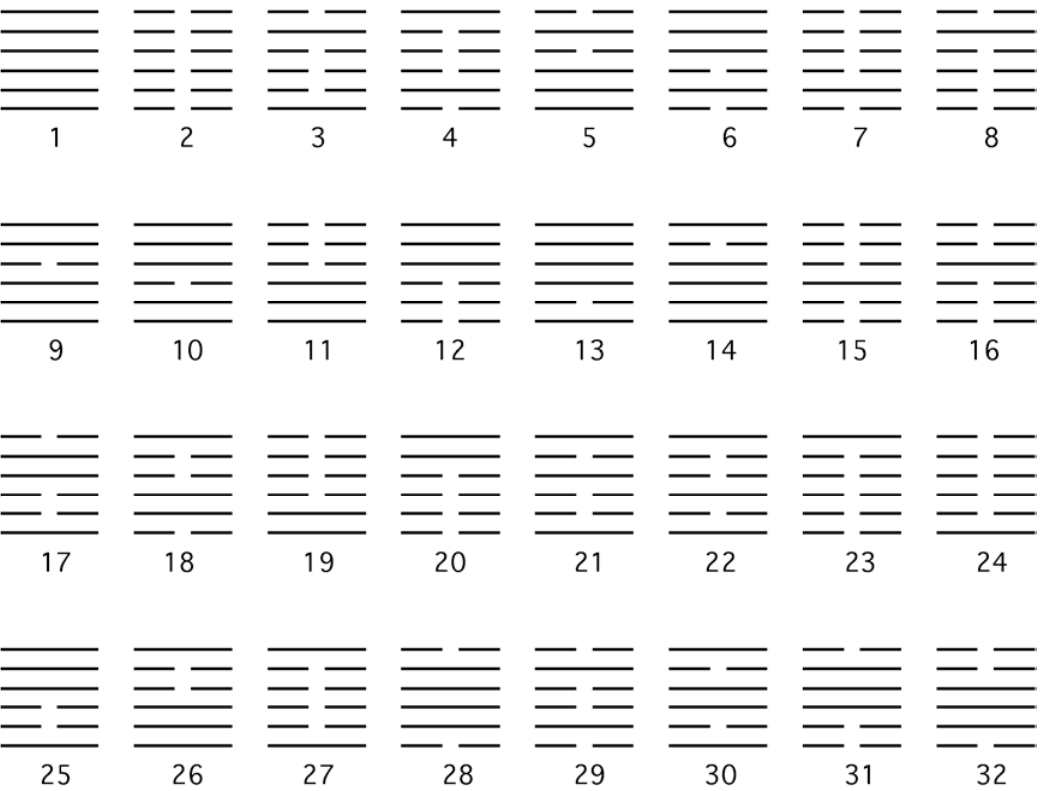
Figure 4.1.a. Hexagrams 1 to 32 of the I